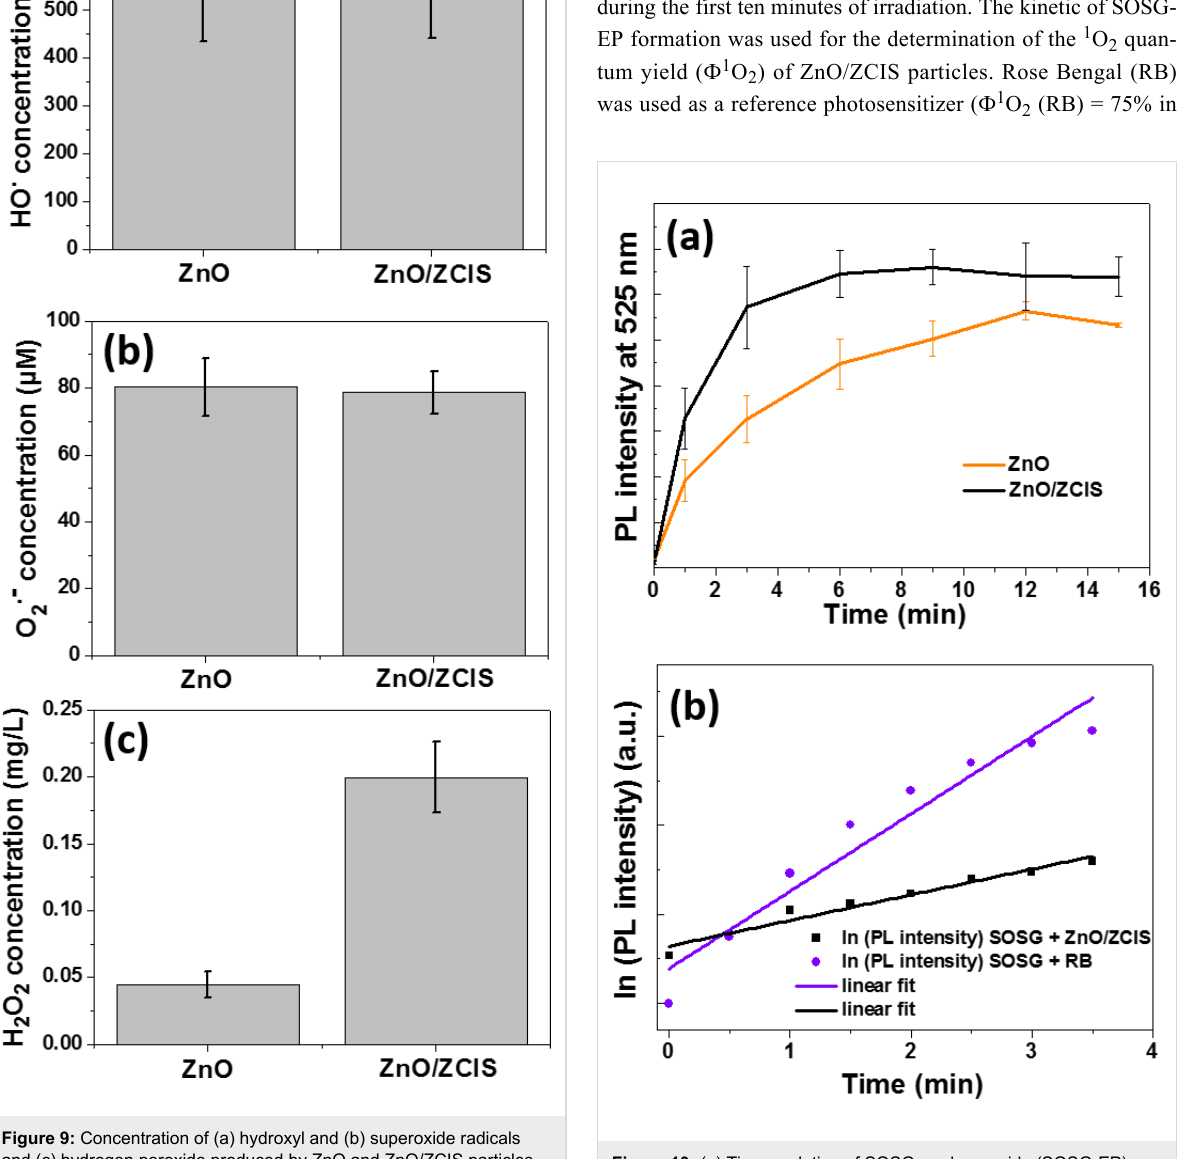
Figure 10: (a) Time evolution of SOSG − endoperoxide (SOSG-EP) photoluminescence (PL) intensity upon irradiation with a Hg–Xe lamp (intensity = 50 mW/cm 2 ) of the ZnO/ZCIS composite and of ZnO. (b) Linear fit of the plots of ln(PL intensity) of